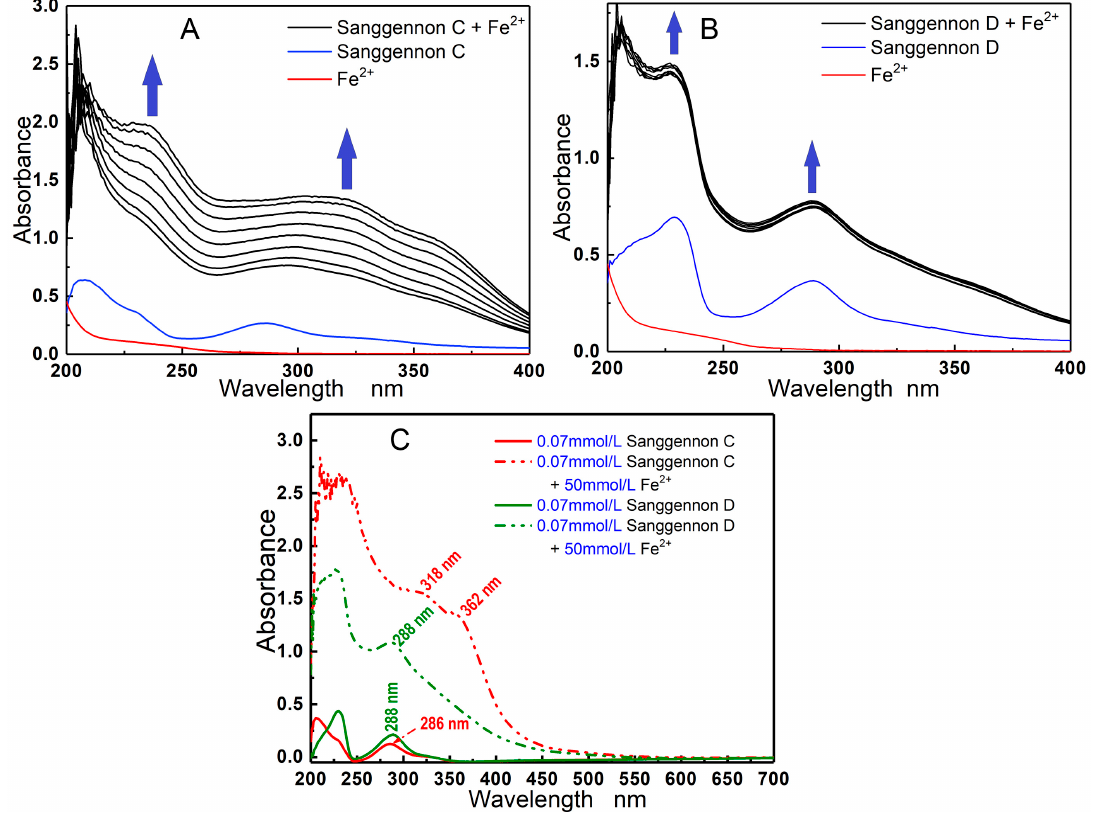
Figure 2. ( A ) UV spectra of reaction mixture of Fe 2+ (50 mmol/L) with sanggenon C (0.07 mmol/L) within the initial 0–24 min; ( B ) UV spectra of reaction mixture of Fe 2+ (50 mmol/L) with sanggenon D (0.07 mmol/L) within the initial 0–24 min; ( C ) the comparison of UV-vis spectra of sanggenon C and sanggenon D in Fe 2+ -binding reaction at 24 min.